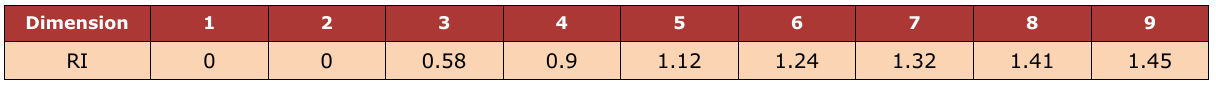
Table 3. Value of Random Consistency Index